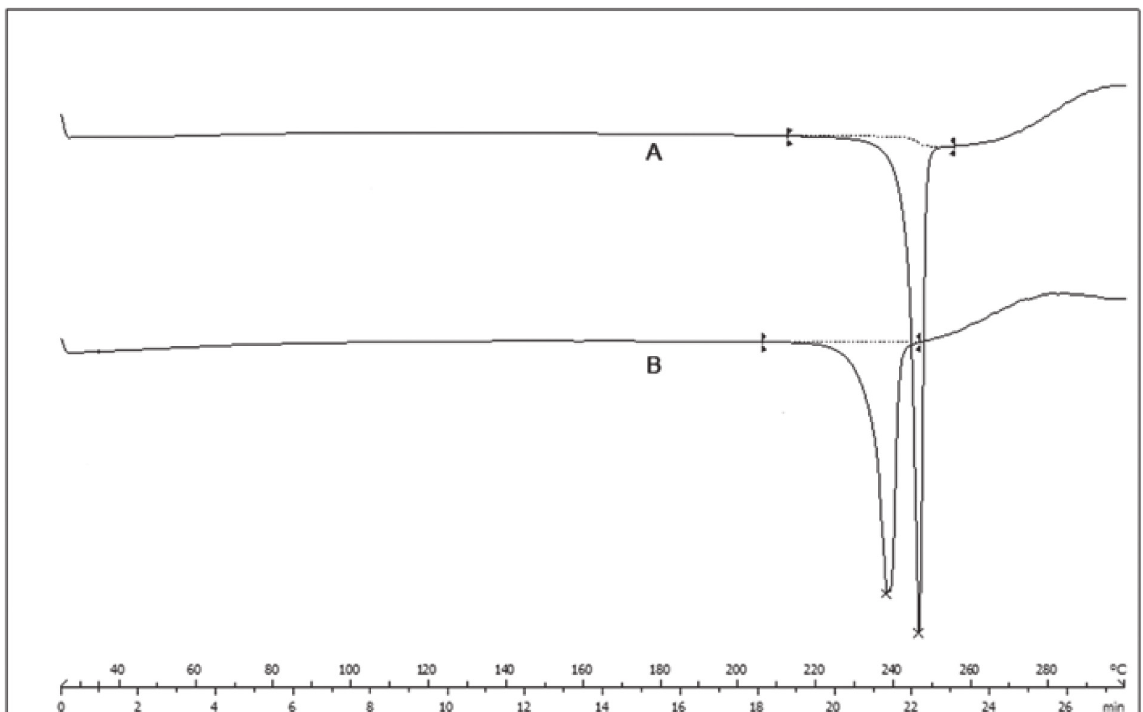
FIGURE 2 - DSC curves of samples A and B at a heating rate of 10